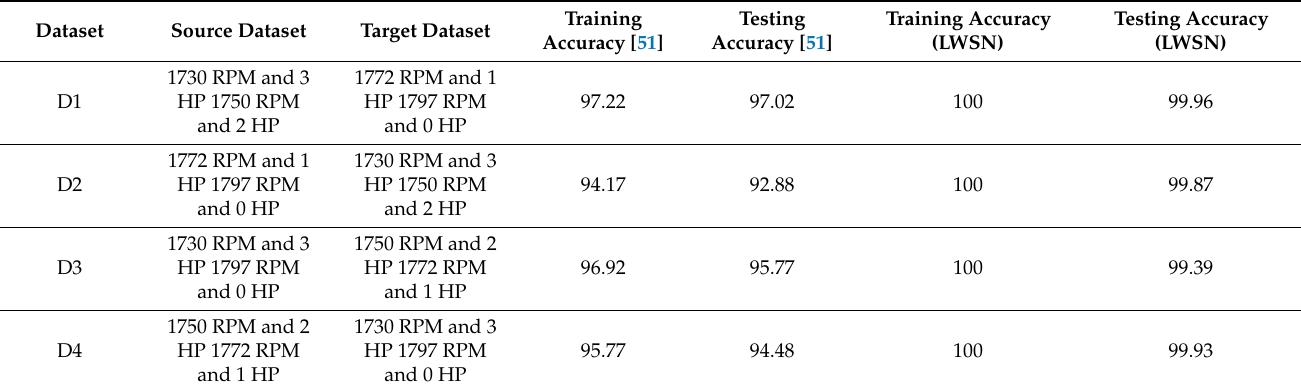
Table 10. Comparison of transfer learning accuracies across different